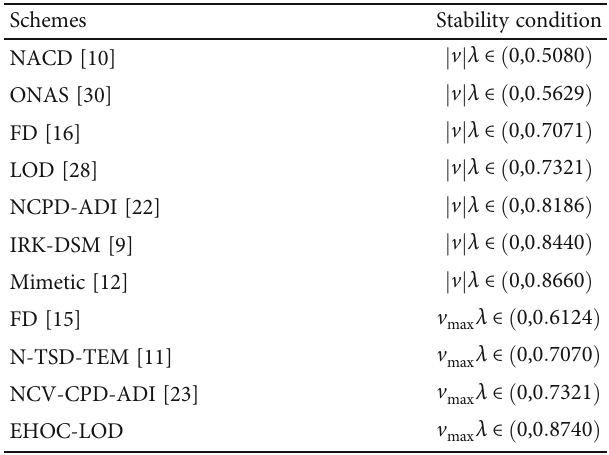
Table 1: The stability conditions of various fi nite di ff erence schemes for solving the 2D wave equations. Schemes Stability